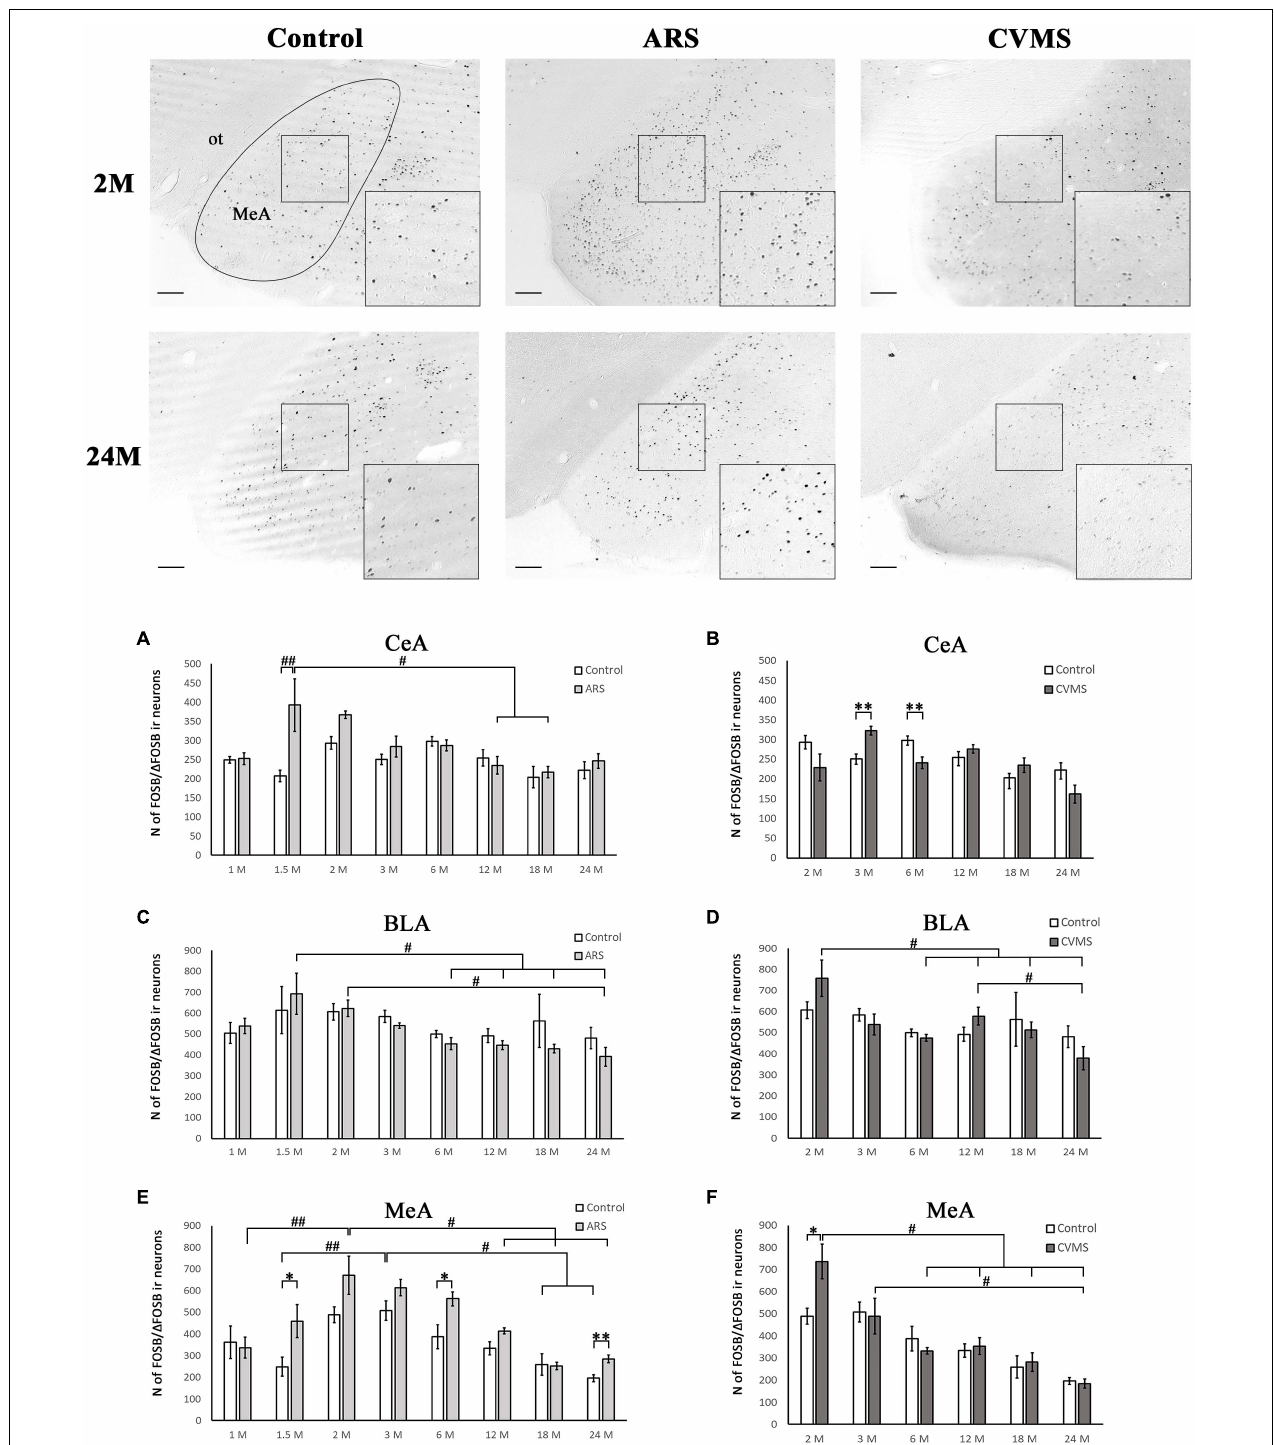
FIGURE 2 | Age-dependent FOSB/ (cid:49) FOSB immunoreactivity (IR) in the amygdala. Representative images of 2- and 24-month-old (M) control, acute restraint stress (ARS) and chronic variable mild stress (CVMS)-exposed rats in the medial amygdala (MeA) at –3.24 mm to the Bregma. The numbers of FOSB/ (cid:49) FOSB IR nuclei were compared among eight age groups as demonstrated in panels (A,B) for the MeA, in panels (C,D) for central nucleus of amygdala (CeA) and in panels (E,F) for basolateral nucleus of amygdala (BLA). Open bars represent the control groups; light gray columns refer to ARS-exposed rats; the dark gray columns indicate the CVMS-exposed animals ( N = 4–7). M, month-old; ot, optic tract. # p < 0.05, ## p < 0.01 according to Tukey’s post-hoc test. ∗ p < 0.05, ∗∗ p < 0.01 according to t -tests. Scale bar: 100 µ m.